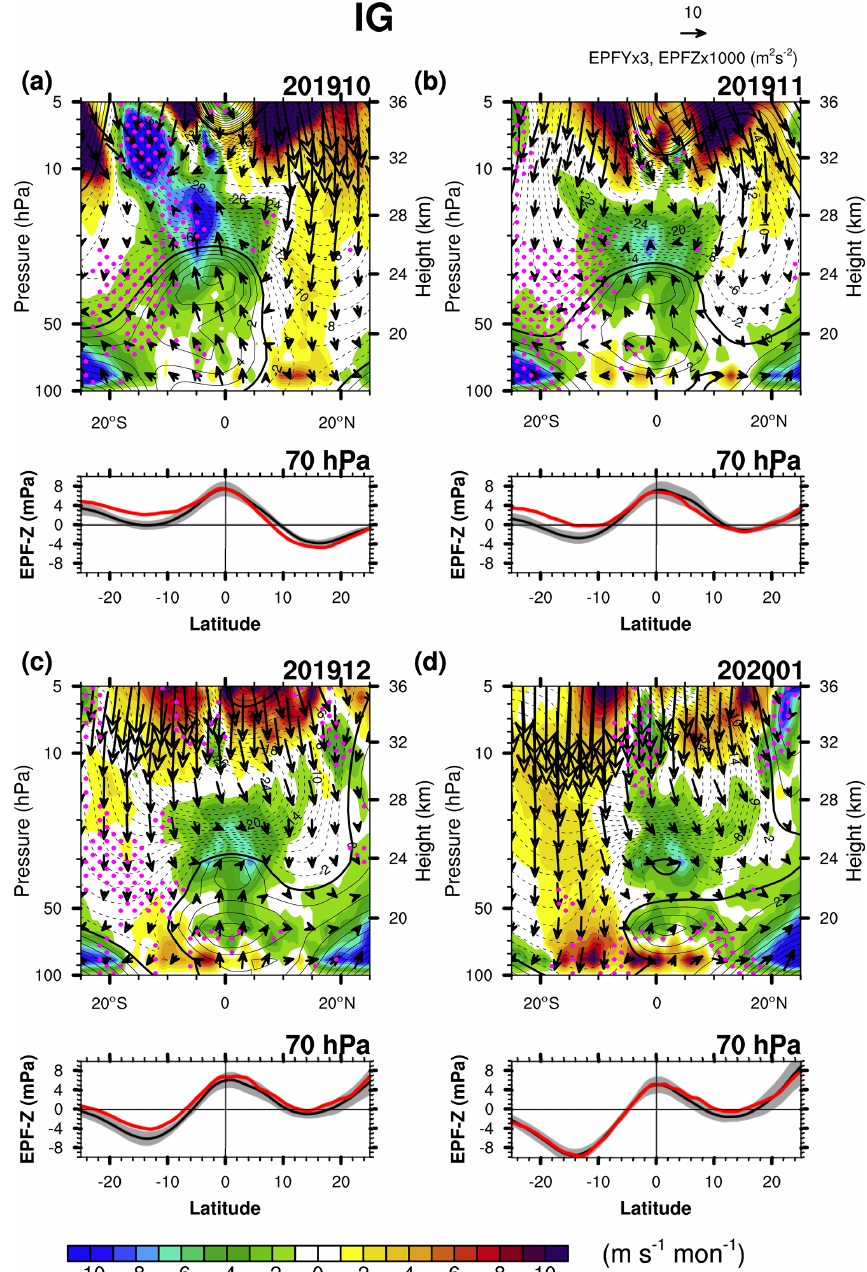
Figure 10. EPF divided by air density (vectors) and EPFD (shading) for the IG waves multiplied by 4 in a latitude–height cross section with the (bottom) meridional distribution of the vertical EP flux at 70hPa in (a) October 2019, (b) November 2019, (c) December 2019, and (d) January 2020 (red) as well as the corresponding monthly climatology (black) with ± 1SD (gray shading). Contours and the magenta stipples are defined the same as those in Fig.